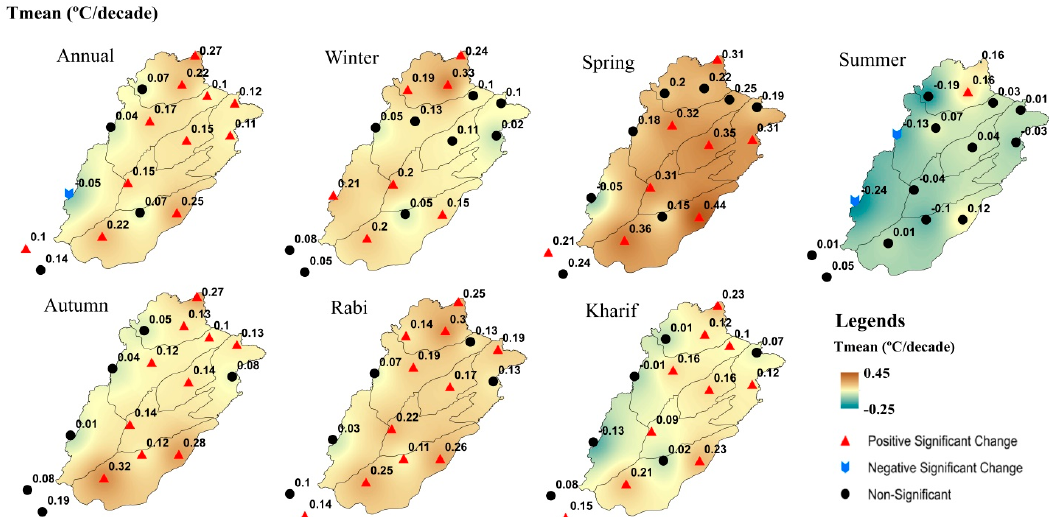
Figure 5. Change per decade and signs of trends at meteorological stations for Tmean for the year, winter, spring, summer, autumn, Rabi, and Kharif in Punjab for the period 1967–2017 .